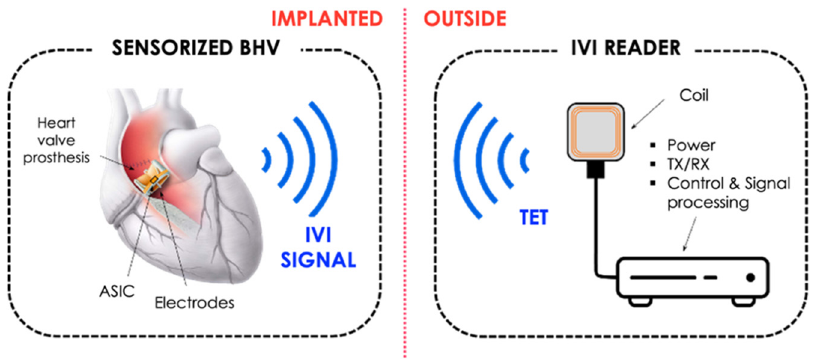
Figure 16. Overall design for an implantable sensorized BHV for IVI sensing.